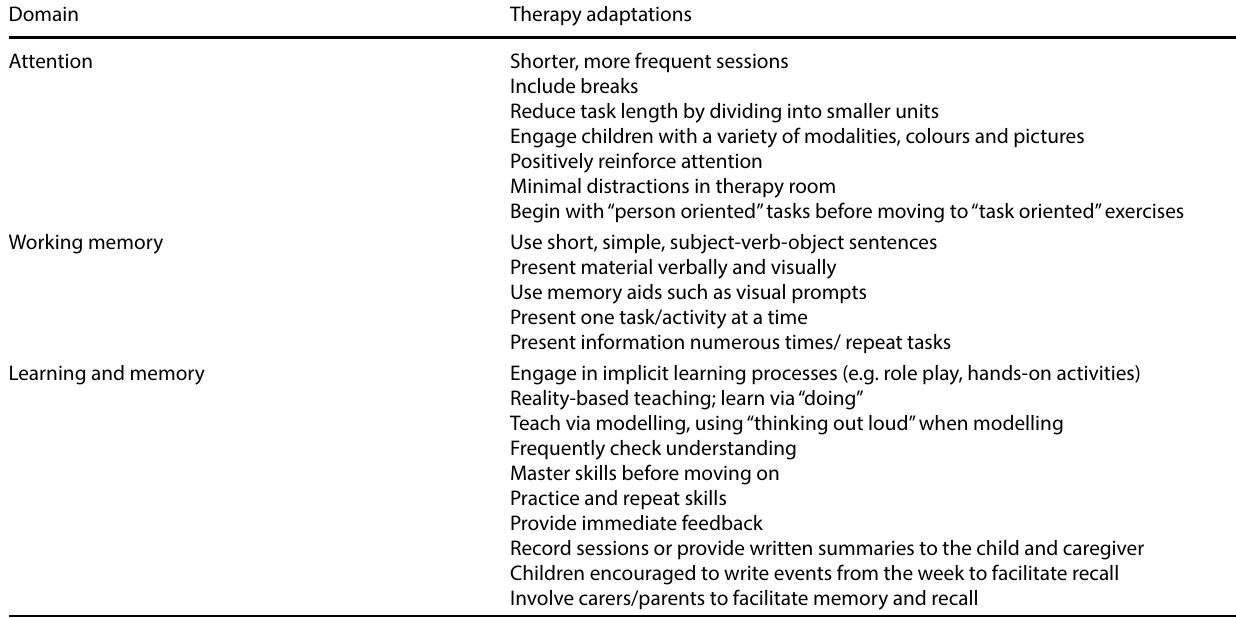
Table of adaptations to CBT for children with intellectual disabilities according to neurocognitive domain Domain Therapy adaptations